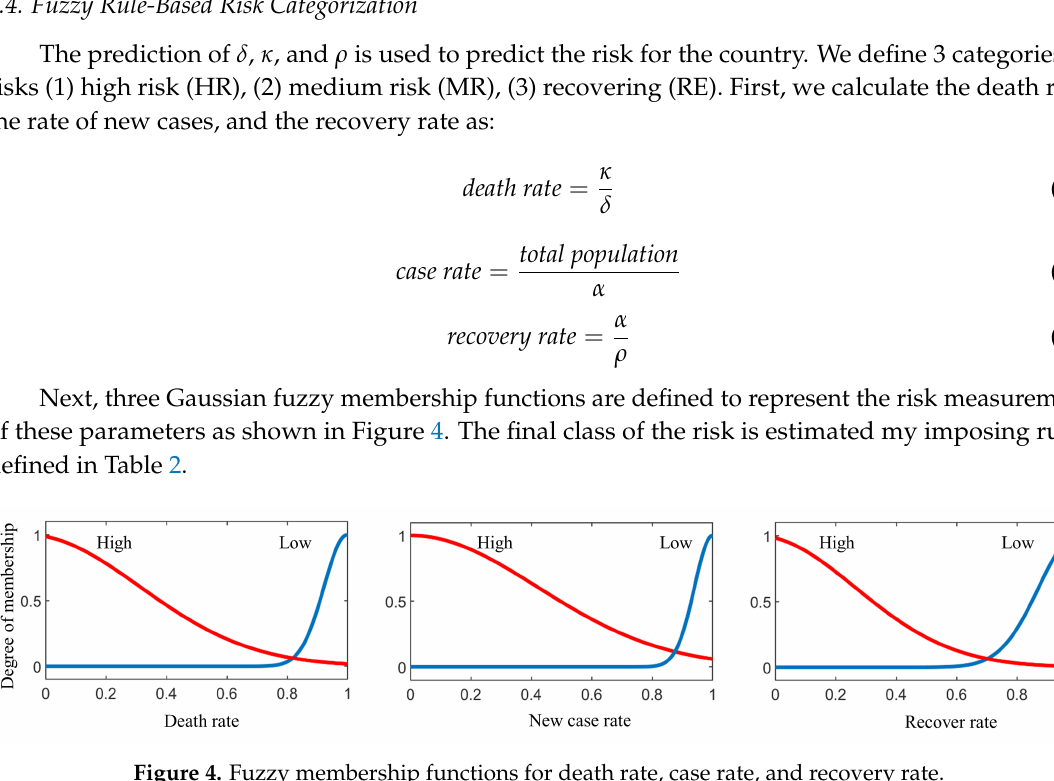
Figure 4. Fuzzy membership functions for death rate, case rate, and recovery rate. Table 2. Fuzzy rules to estimate the risk factor of a